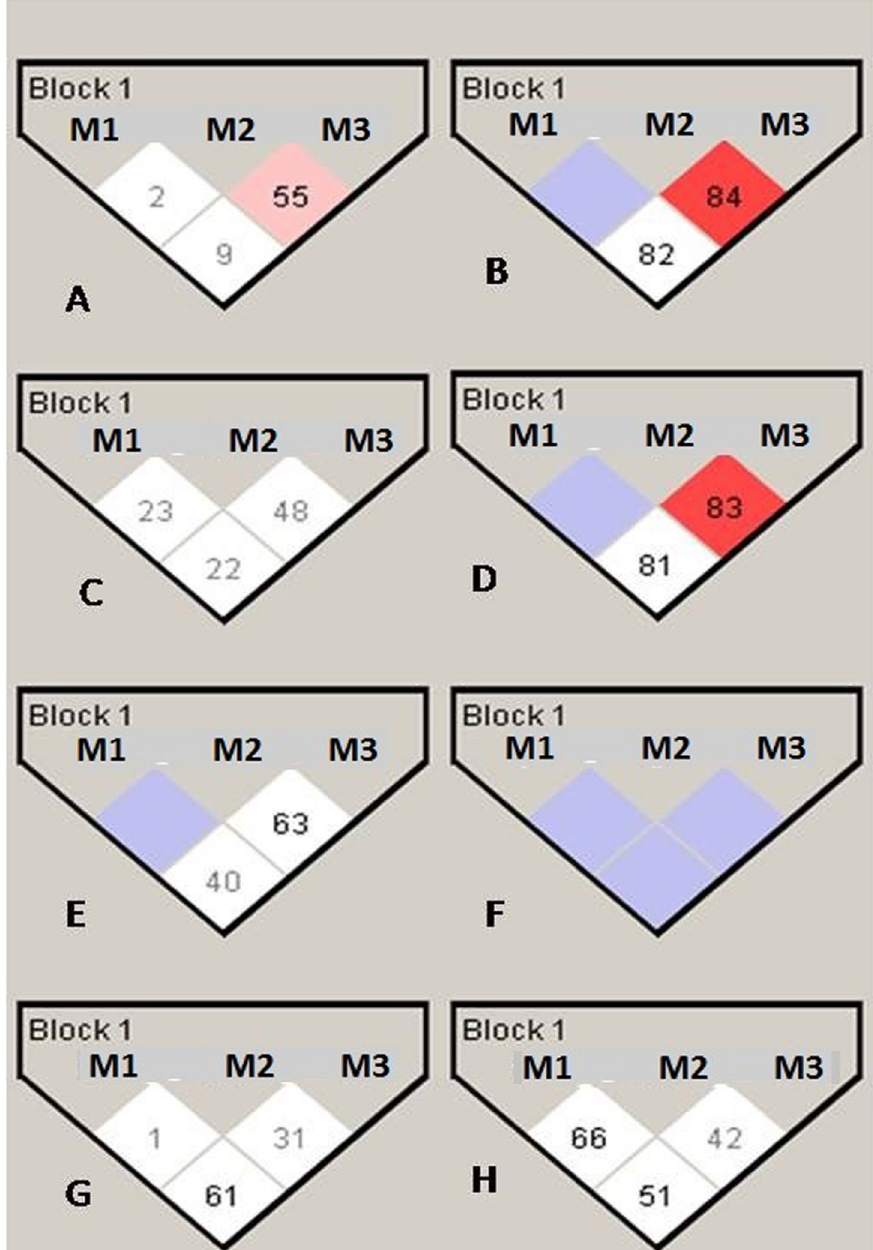
Figure 1. LD between CDK5 variants in all controls ( A ), all probands ( B ), male controls ( C ), Male probands ( D ), female controls ( E ), female probands ( F ), Father of probands( G ), Mother of probands ( H ). Variants (M1,2,3); rs2069454, rs22069456, rs2069459.